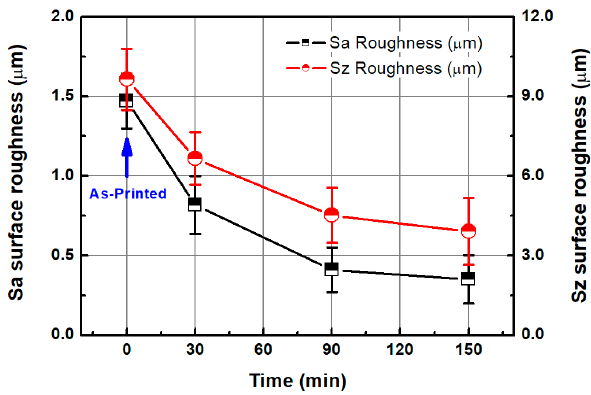
Figure 4. Sa and Sz values as functions of CMP processing time in one-step polishing